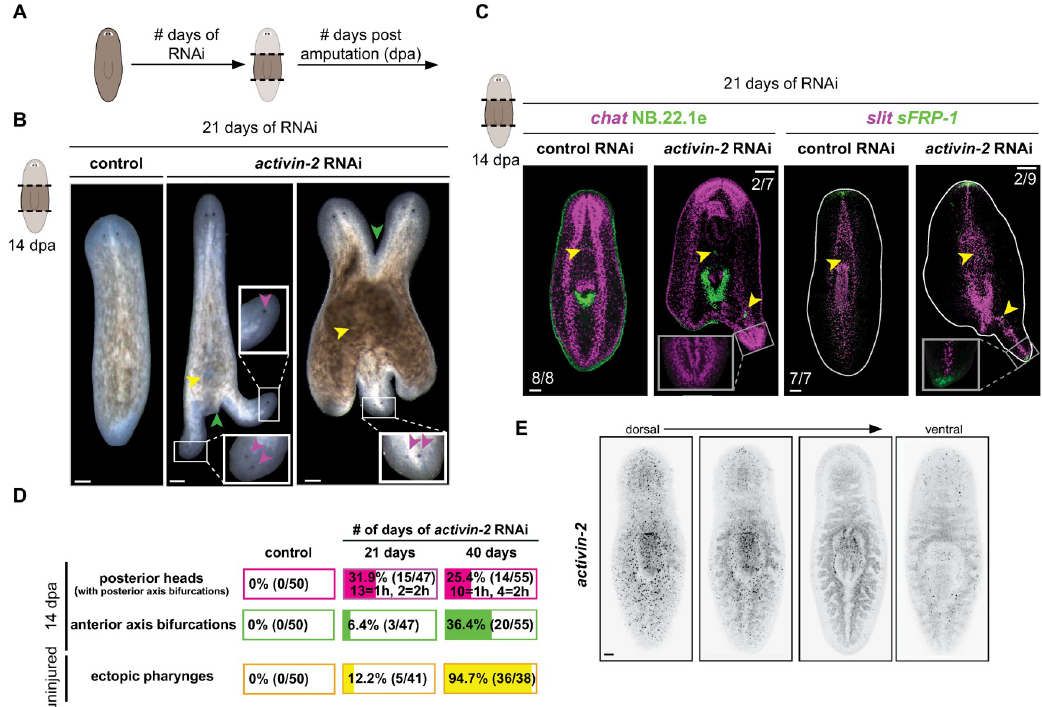
Fig 1. activin-2 is required for regeneration polarity and regeneration of AP axis pattern. (A) Schematic of RNAi experiments where the number of days on RNAi and number of days post amputation (dpa) are specified separately. (B) Regenerating activin-2 RNAi animals. Insets show magnified ectopic heads and eyes (magenta arrows). Green arrows, AP axis bifurcations; yellow arrows, ectopic pharynges. (C) FISH shows (left) CNS ( chat+ ) and mouth and esophagus ( NB . 22 . 1e )and (right) PCG expression (midline slit+ ; anterior sFRP-1+ ) in ectopic axes. Inset: magnified view shows ectopic anterior. Yellow arrows: esophagi. (D) Quantification of posterior heads (based on presence of eyes) and axis bifurcations in regenerating animals, and ectopic pharynges seen in uninjured animals (DAPI) at 21 and 40 days after first RNAi. h is the number of posterior heads in a given animal. (E) activin-2 expression pattern by FISH, from dorsal to ventral. All images are anterior up. Scale bars, 200 μ m. Numbers of representative animals are indicated on bottom left of each panel.